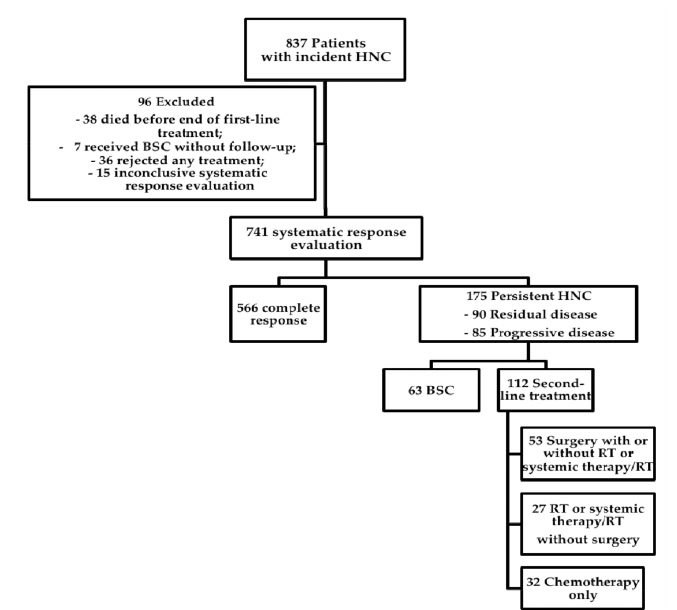
Figure 1. Overview of study population. Flow chart of the course of disease in 837 patients with incident head and neck cancer treated between 2008 and 2016 in a tertiary head and neck oncology center. A systematic response evaluation was performed 8–10 weeks following end of first-line treatment in 741 patients. Of these, 175 had persistent disease and were analyzed in detail. Residual disease included partial response and no change. Abbreviations: HNC: Head and neck cancer, BSC: Best supportive care, RT: Radiotherapy.